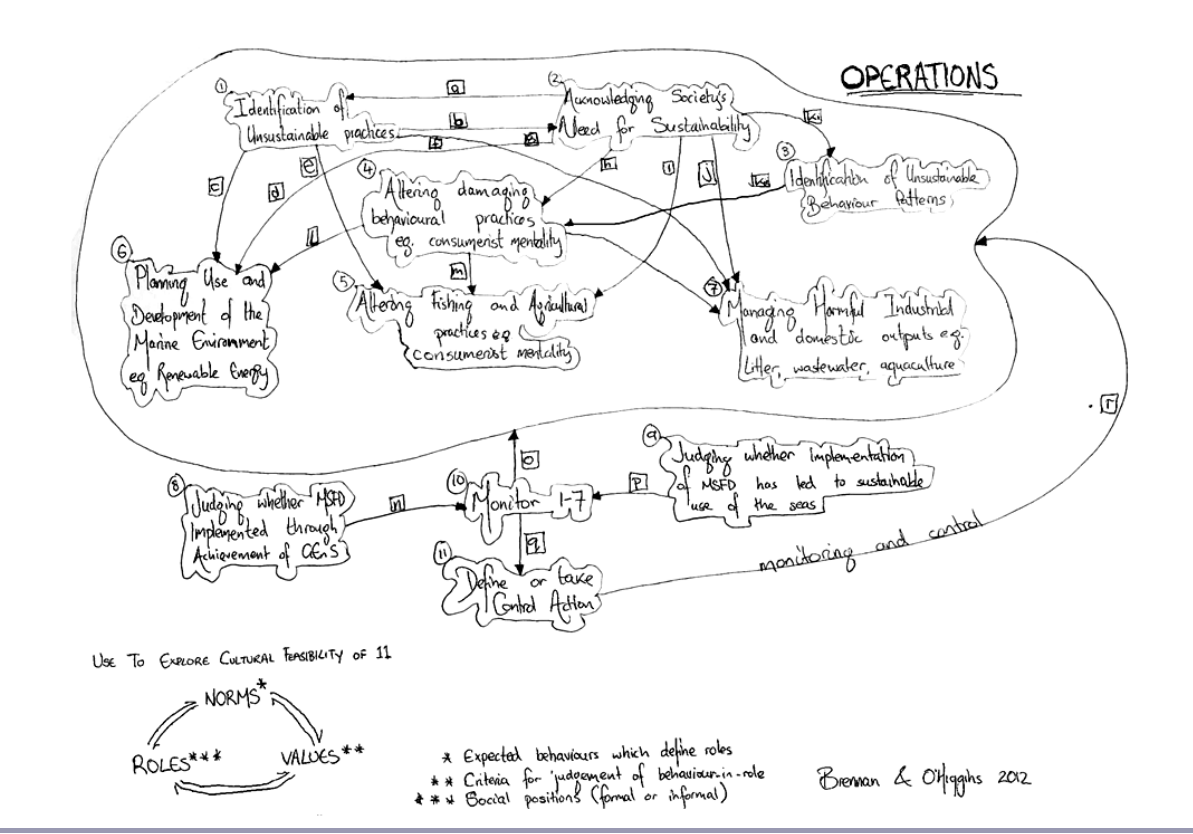
Fig. 1. Initial soft systems model articulating the interaction of social, cultural, economic, and environmental forces in the delivery of Good Environmental